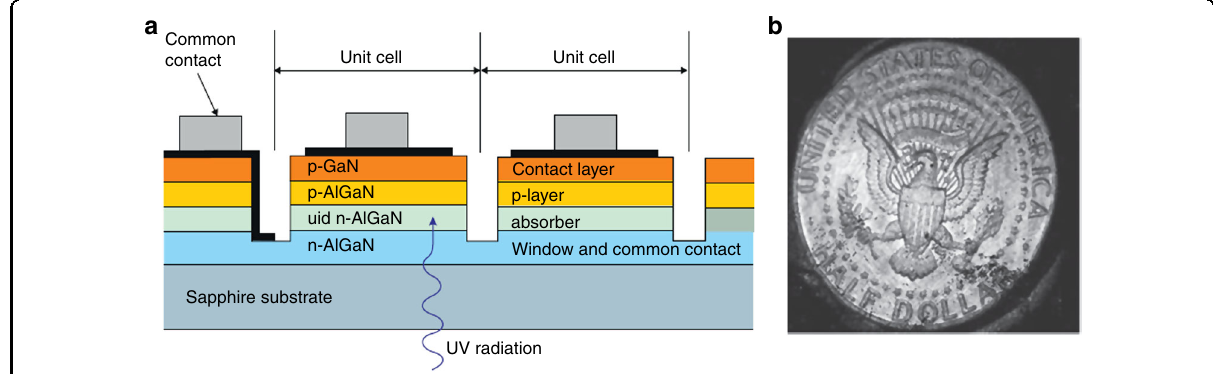
Fig. 17 256 × 256 AlGaN UV FPA structure and imaging. a Schematic cross-sectional diagram of AlGaN-based FPA structure. b UV re fl ection image of a US dollar coin with the fabricated FPA. Reprinted with permission from Lamarre et al. 266 . Copyright WILEY-VCH Verlag Berlin